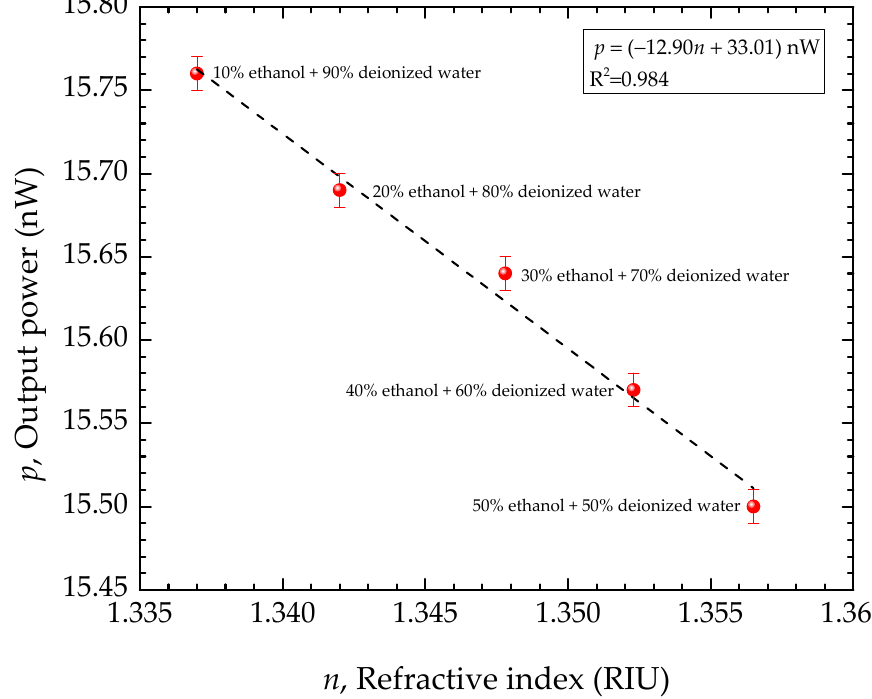
Figure 4. Refractive index characterization of the ethanol and deionized water mixtures. Measurements of refractive index performed using an Abbe refractometer.